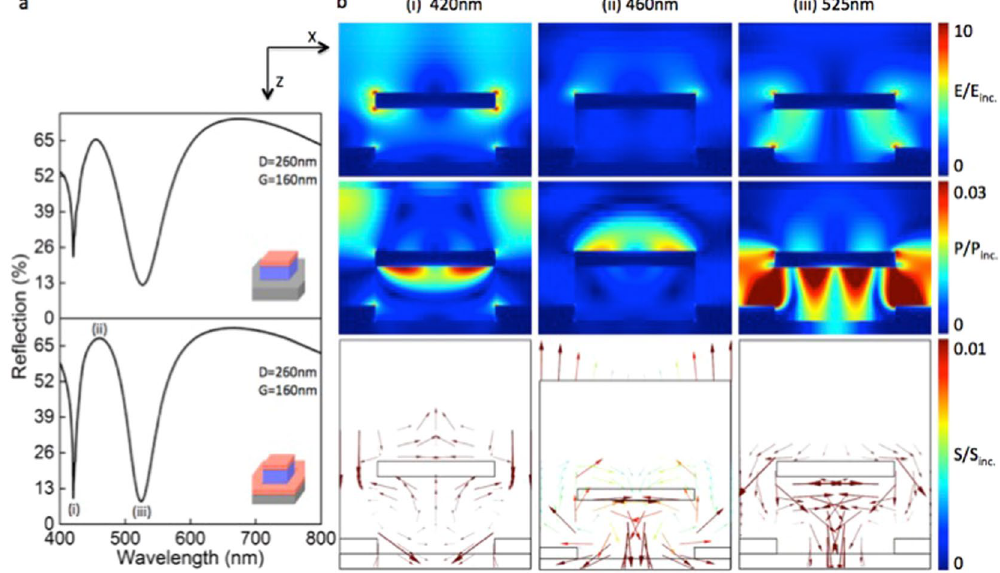
Figure 5. Numerical analyses of the spectral and electromagnetic behavior of the plasmonic structures using FDTD algorithm. ( a ) Calculated reflectance for the structures with (bottom) and without (top) back reflector, confirms the presence of multiple plasmonic resonances in both the cases. It is clear from the bottom figure that the strength of plasmonic light absorption increases with the presence of back reflector for both the resonances at (i) and (iii). ( b ) Electric field enhancement plots (top), time averaged power flow plots (middle) and Poynting vector plots (bottom) for the structure D = 260 nm with G = 160 nm at spectral positions marked in ( a ). (i) Dip 1 corresponds to the plasmonic resonance at 420 nm and it enhances the light absorption in to the substrate through the polymer nano pillar. (ii) Enhanced electric field due to the strongly radiating dipole resonance at 460 nm scatter coherently to form the strong reflective peak R peak . (iii) The Dip 2 corresponds to a strong LSPR at 525 nm enhances the electric field around the nano hole which in turn facilitates increased light absorption in to the substrate. In all simulations normal incidence of plane wave was carried out with the electric field polarized in the x-axis and the k-vector in the z-axis pointing from